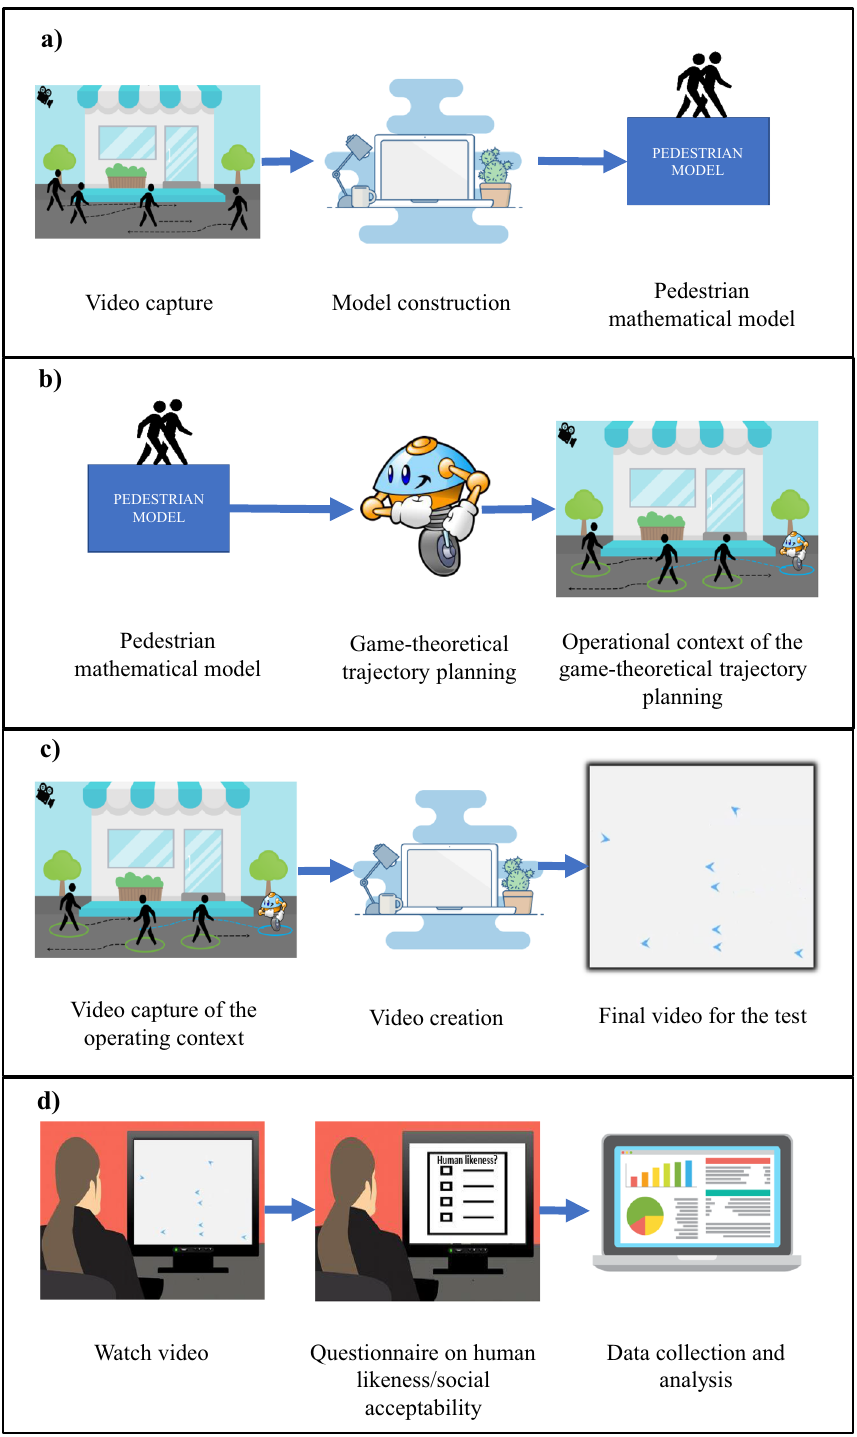
Figure 1. Graphical abstract of the procedure. ( a ) Construction of the game-theoretical model for human motion; ( b ) creation of the game-theoretical trajectory planner based on the model previously designed, creation of the virtual environment, and evaluation of the performance parameters; ( c ) creation of the videos with pedestrians and the robot controlled by our game-theoretical trajectory planner; ( d ) survey questionnaire, data collection and